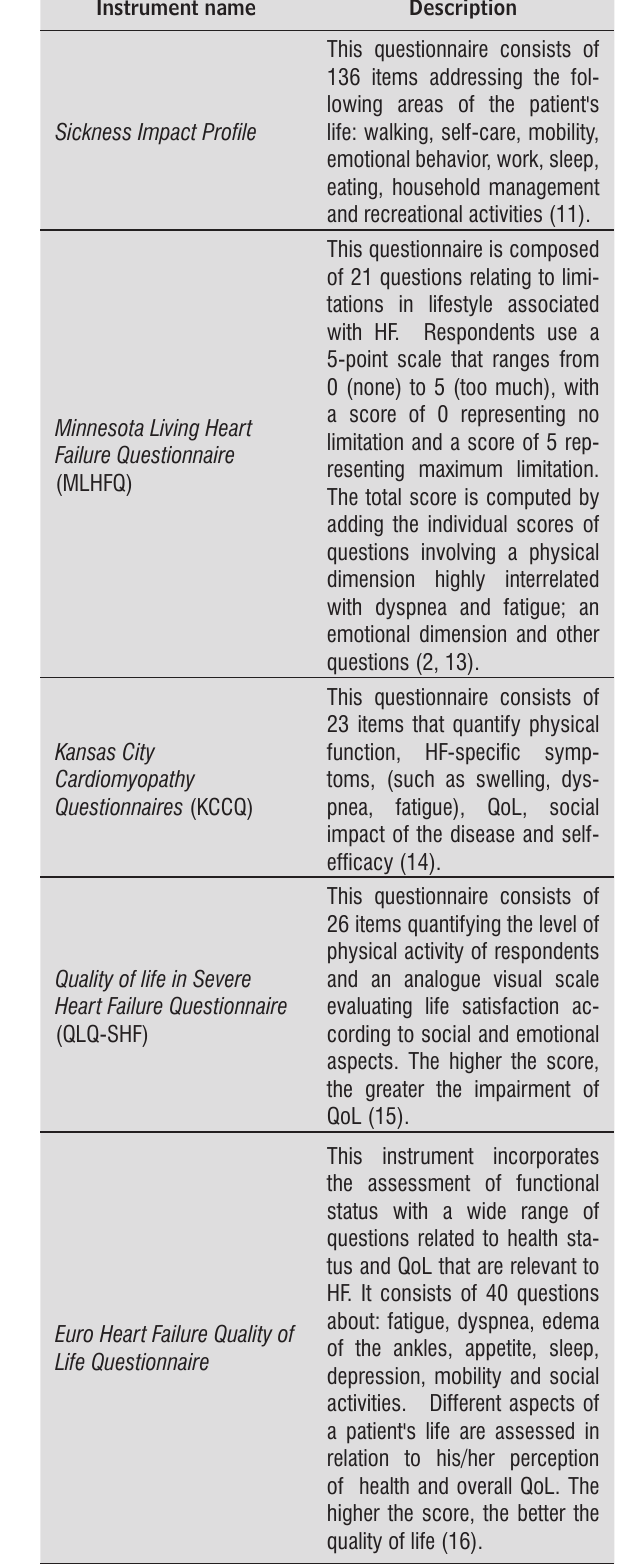
Table 1 - Summary and description of the question- naires found in the literature